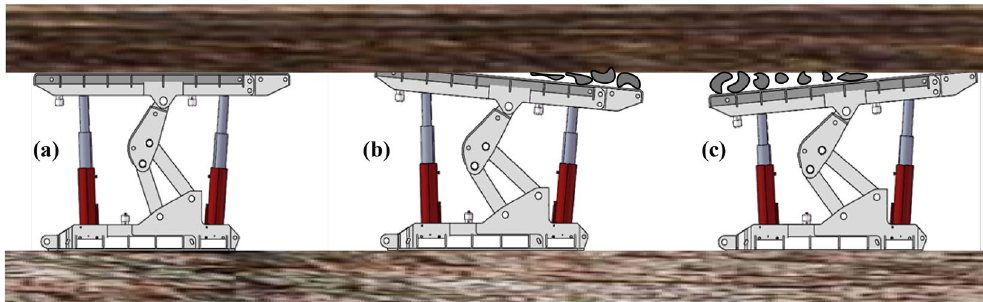
Figure 1. Three postures of the advance hydraulic support when the roadway floor is horizontal: ( a ) ideal supporting posture; ( b ) base “horizontal” and top beam “head up”; and ( c ) base “horizontal” and top beam “low head”.